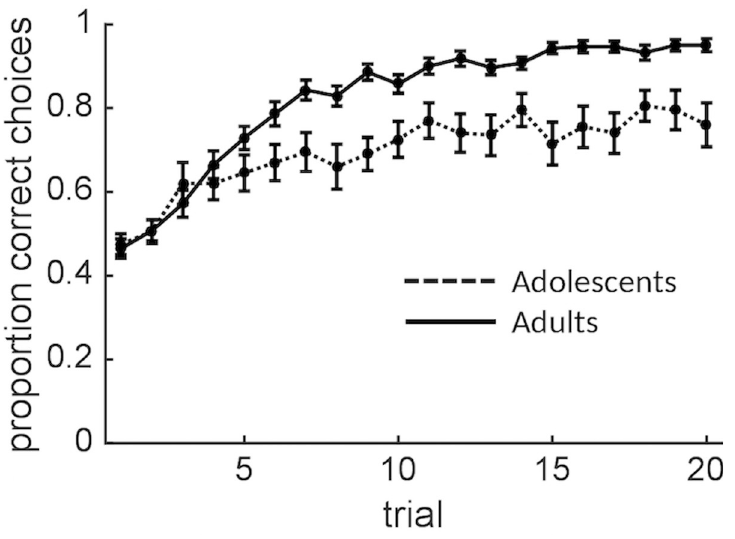
Fig 4. Choice accuracy as a function of trial and age group. Error bars indicate standard